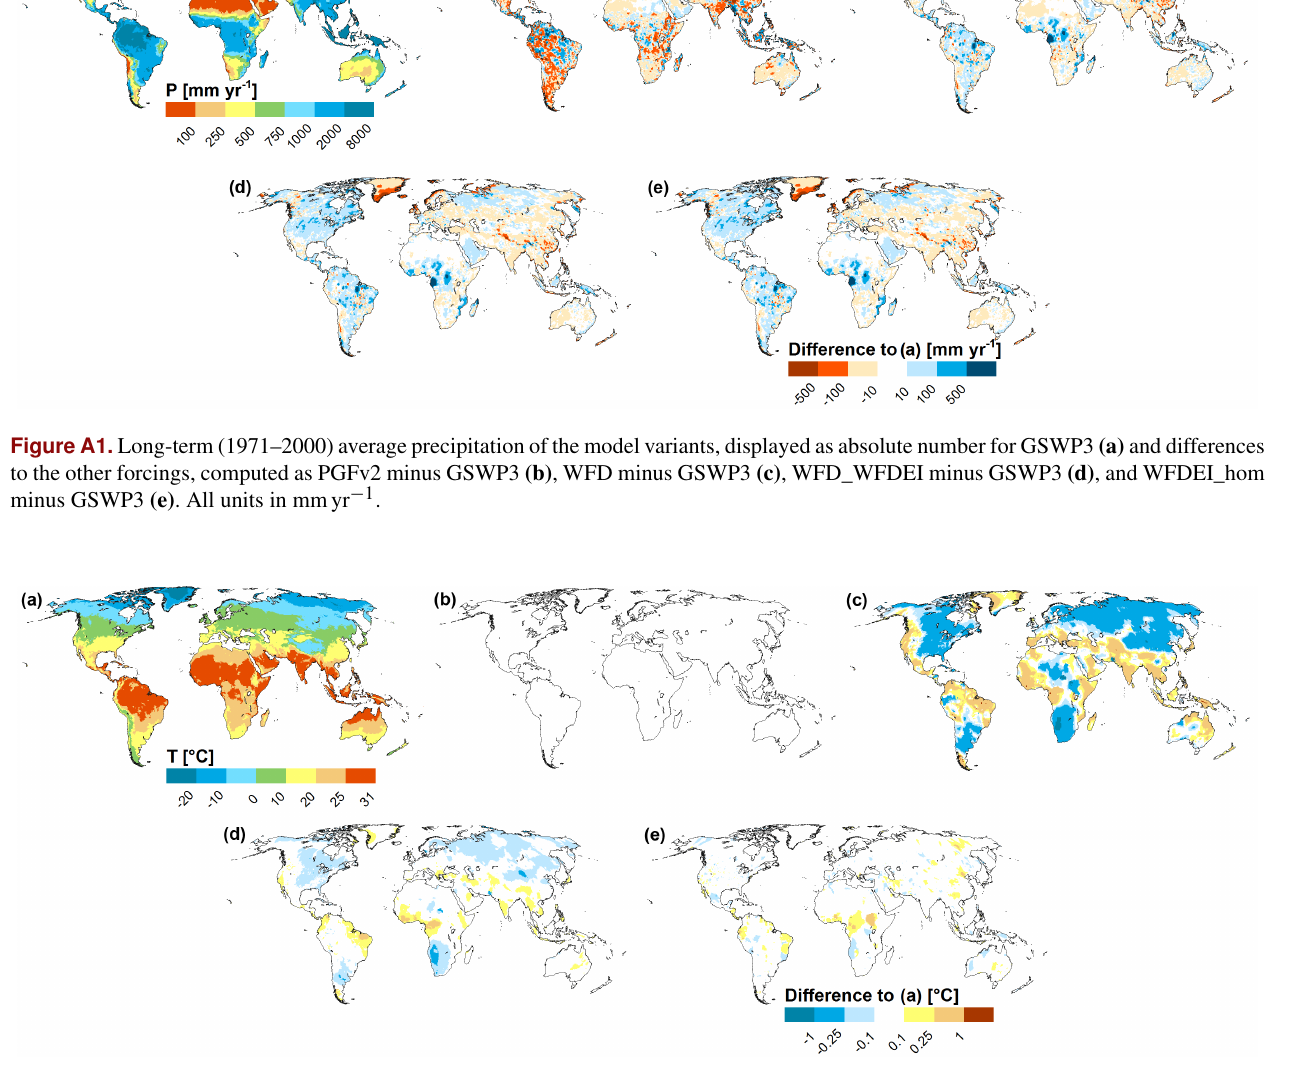
Figure A2. Long-term (1971–2000) average temperature of the model variants, displayed as absolute number for GSWP3 (a) and differences to the other forcings, computed as PGFv2 minus GSWP3 (b) , WFD minus GSWP3 (c) , WFD_WFDEI minus GSWP3 (d) , and WFDEI_hom minus GSWP3 (e) . All units in ◦